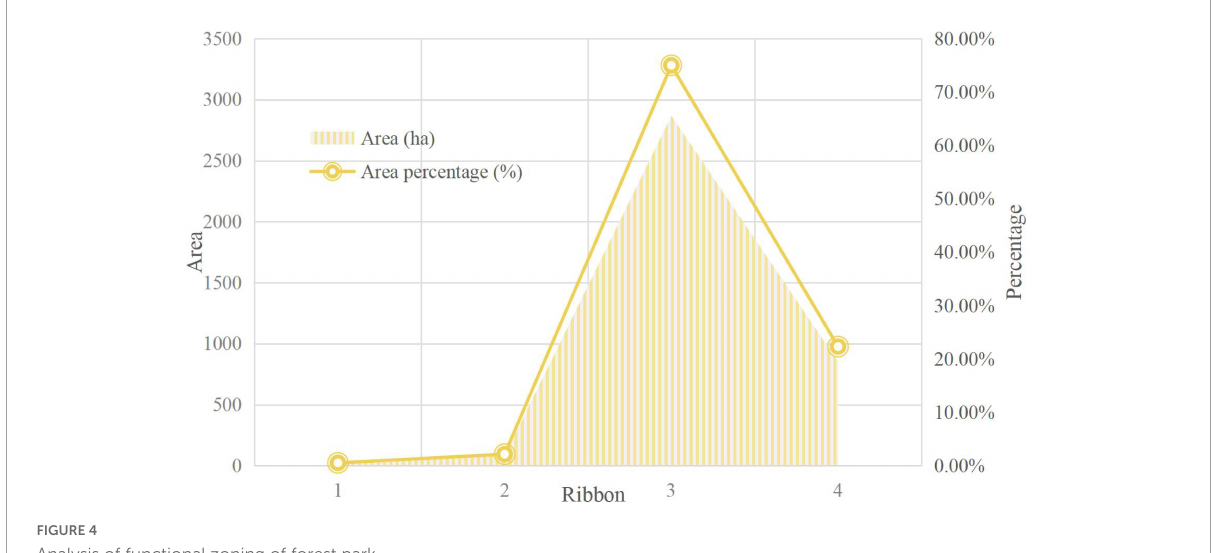
FIGURE4 Analysis of functional zoning of forest